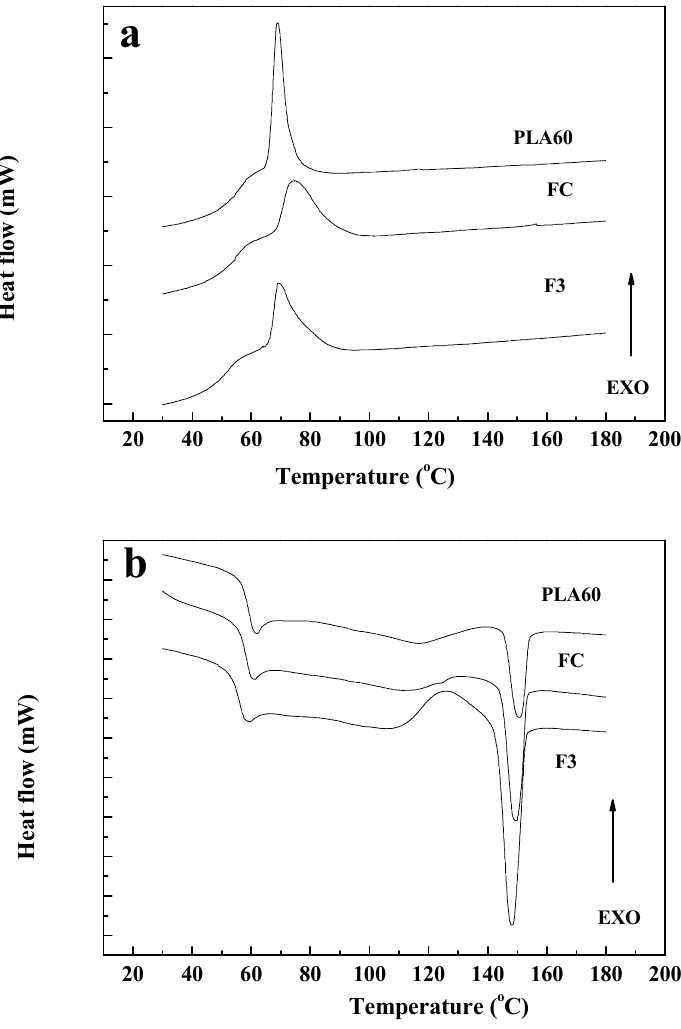
Figure 5. DSC thermograms for PLA60 and bio-based polymer fibers FC and F3: ( a ) Cooling and ( b ) second heating.